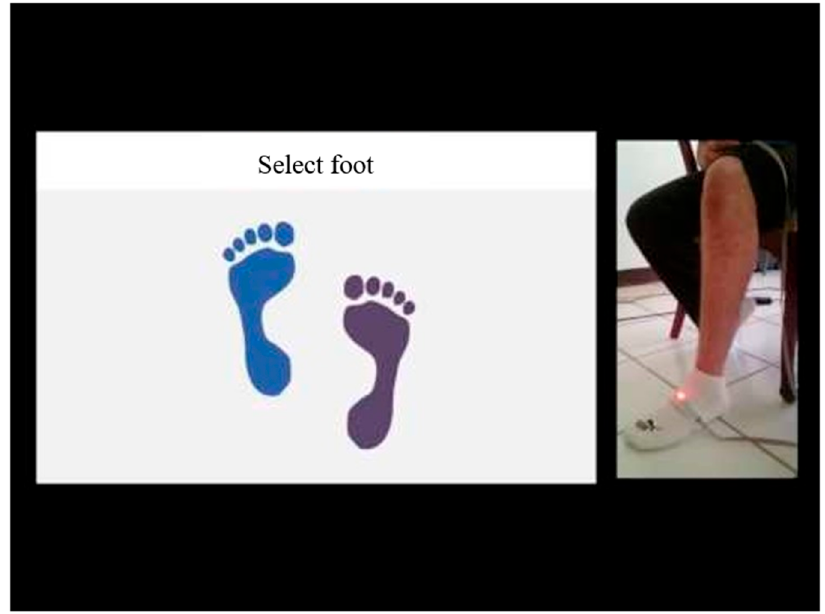
Figure 7. Experimental validation showing the graphical user interface and the patient.